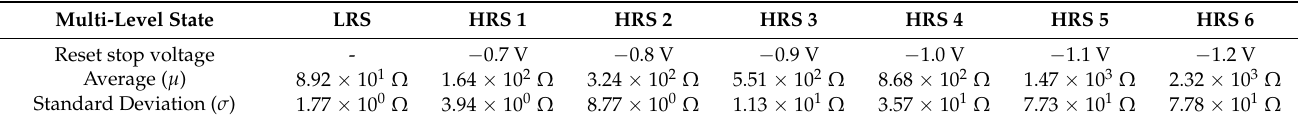
Figure 8. Multi-level resistance characteristics for the IGZO:N memristor devices by modulating the magnitude of V stop values from −0.7 to −1.2 V (in −0.1 V step). ( a ) BRS I–V characteristic curves. ( b ) Cumulative probability recorded through 30 cycles of DC BRS operation. ( c ) Retention characteristics over 10 4 s at room temperature (25 °C) and high temperature (85 °C). ( d ) Relationship between average resistance values of HRS and magnitude of V stop value. Table 4. Average resistance values and standard deviations of multi-level states according to the V stop step in IGZO:N memristor devices.